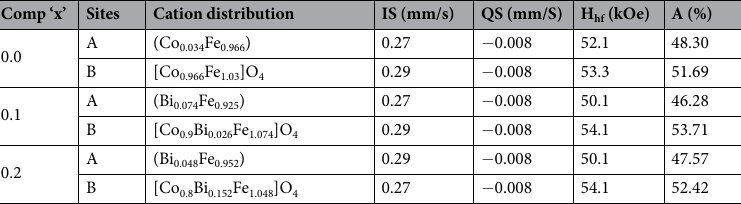
Table 3. The IS, QS, H f and A values, obtained from Mossbauer analysis, of CBF for various Bi 3 + i.e. x